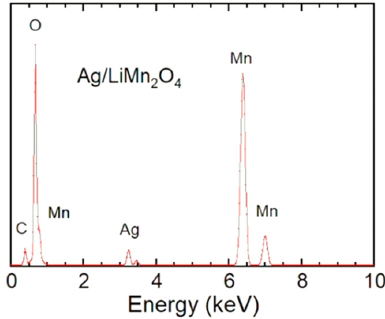
Figure 5. EDX spectrum of the Ag / LMO(v) sample.